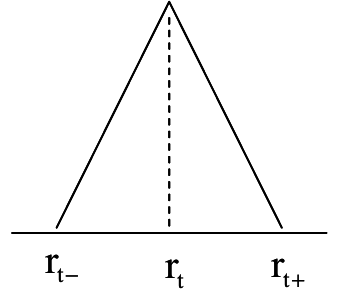
Figure 6. The t-th linguistic context in consequent